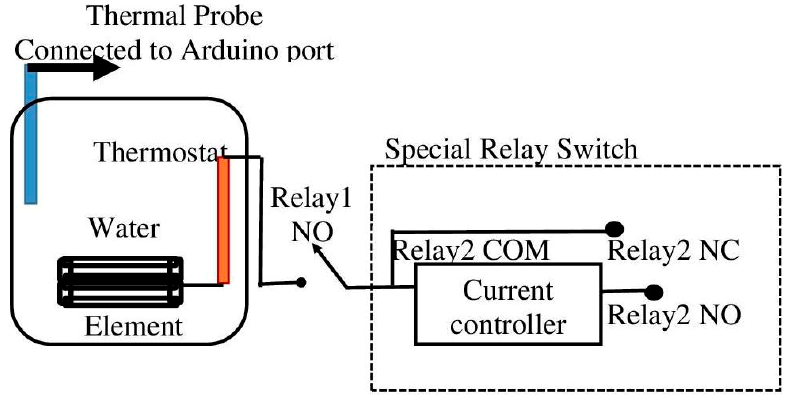
Figure 6. One current controlled element.